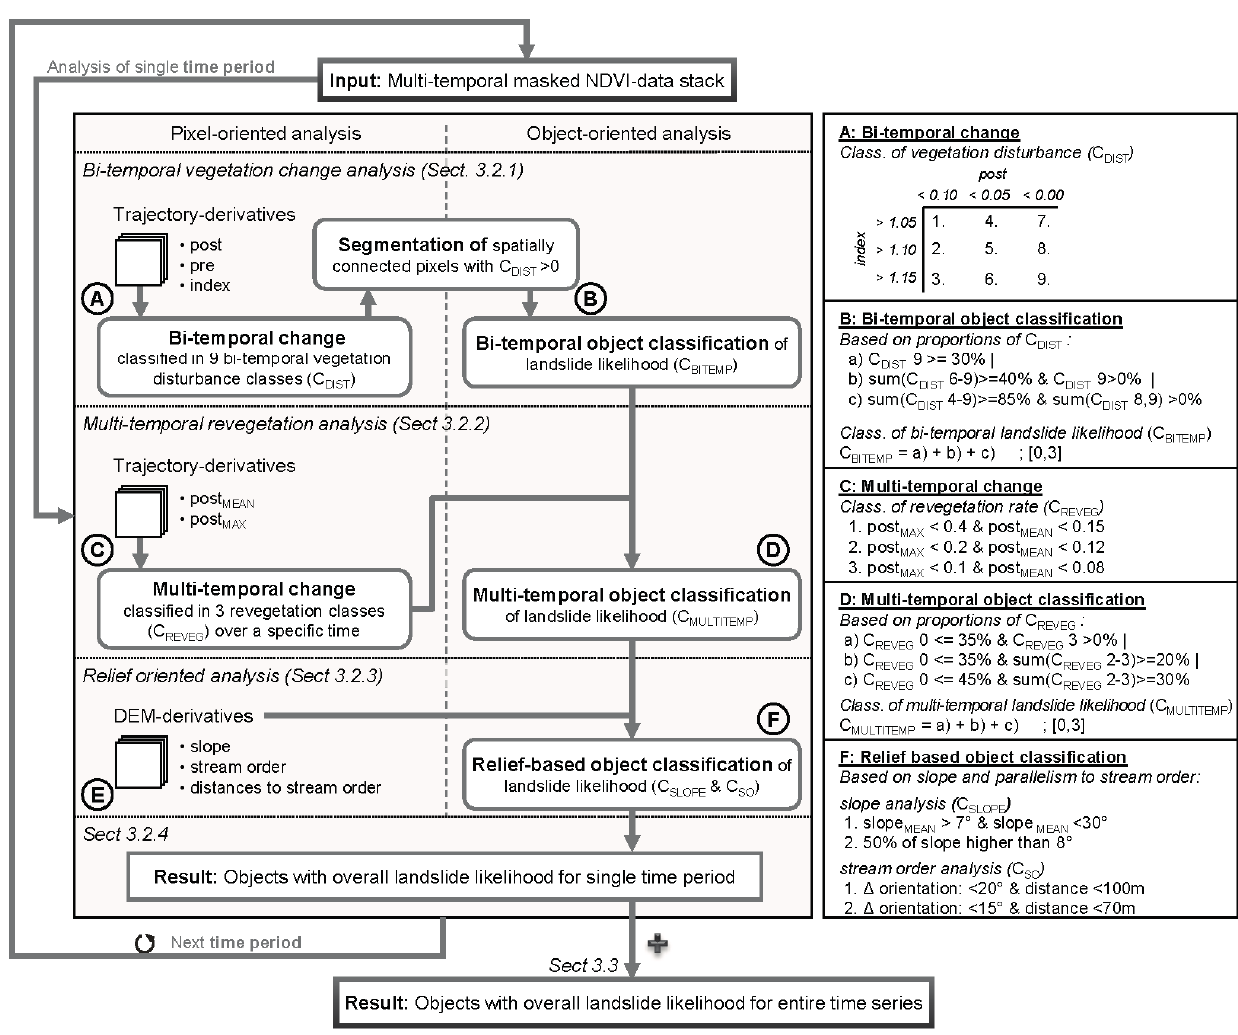
Figure 7. Multi-temporal landslide identification approach based on temporal NDVI-trajectories and relief oriented analysis. ( Left ) Processing scheme; ( Right ) Implemented thresholds for steps A to